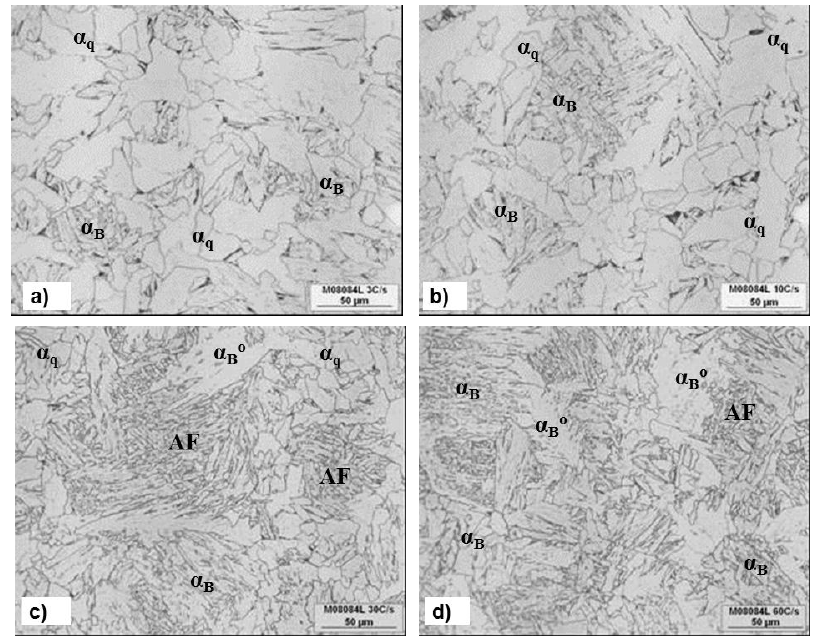
Figure 7. Optical microstructures for 0.024% Nb UCS dilatometer samples cooled at ( a ) 3 °C/s α q + α B , ( b ) 10 °C/s α q + α B , ( c ) 30 °C/s α B + α B ° + AF and ( d ) 60 °C/s α B + α B ° + AF.